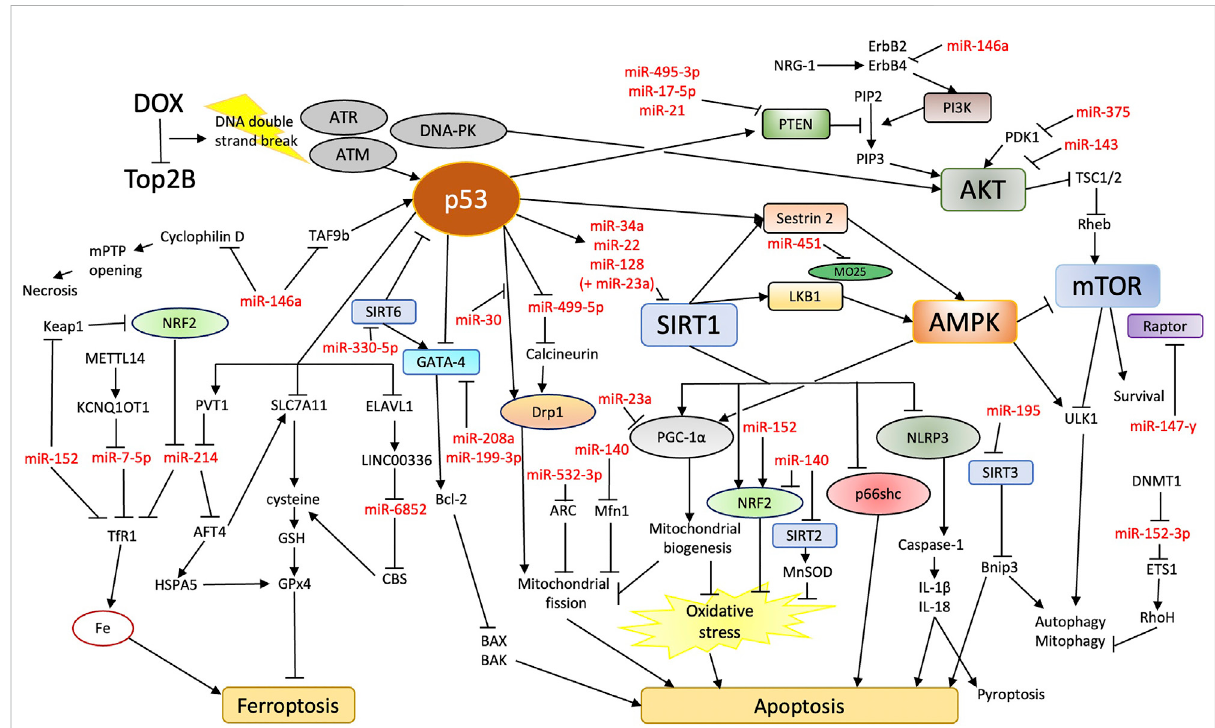
FIGURE 1 Overview of potential miRNA involvement in DIC. DOX treatment increases apoptosis and ferroptosis in cardiomyocytes. Rather than oxidative stress, DOX inhibition of Top2B and subsequent DNA damage response may be the primary contributor to cardiomyocyte death. miRNAs may aid in the regulation of molecular pathways that connect DNA damage response and